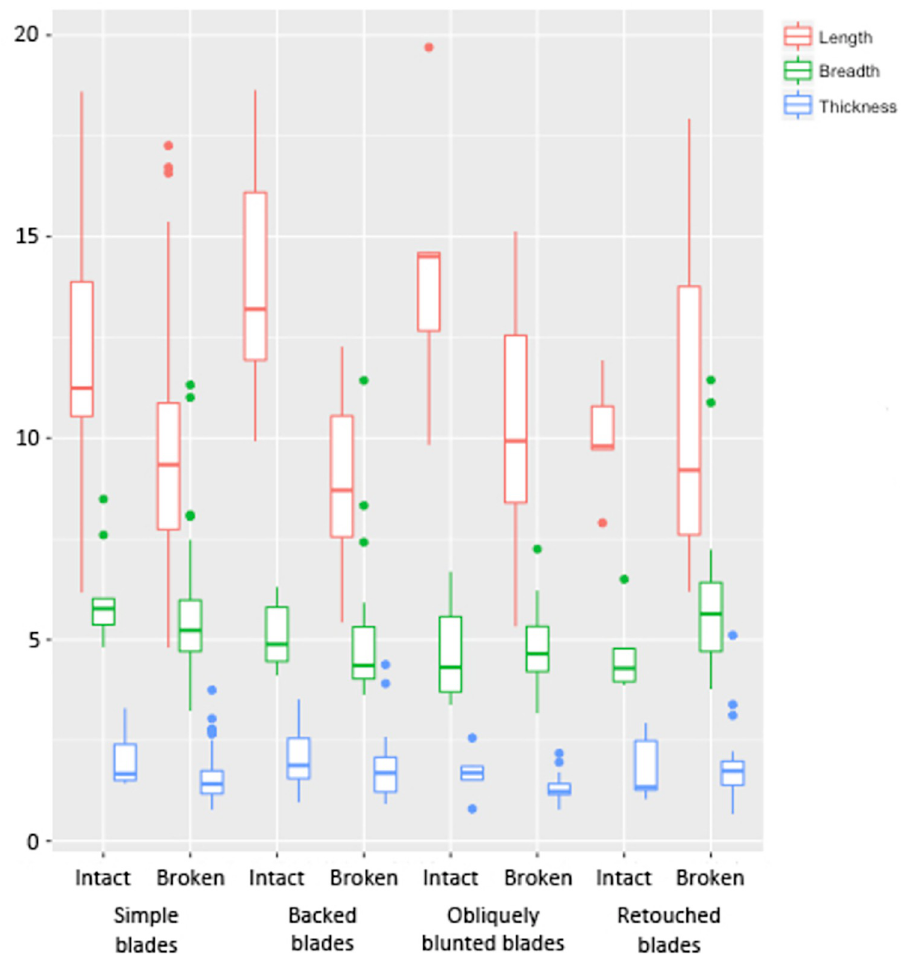
Fig 3. Boxplot showing the length, breadth and thickness (in mm) of the blades from Vaharvo